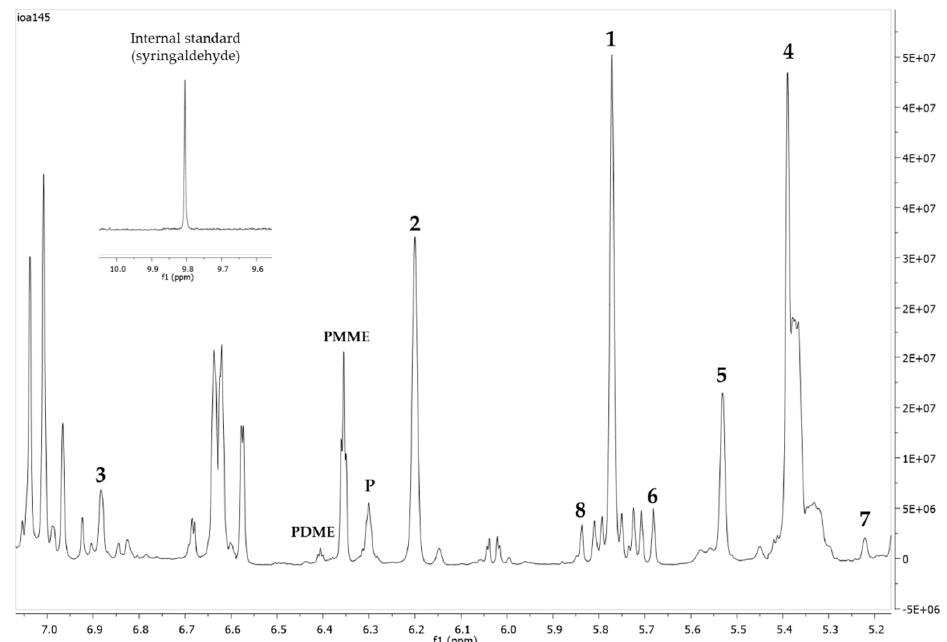
Figure 2. 1 H-NMR spectrum (400 MHz, CDCl 3 , δ -values in ppm) of black pine (P. nigra Arn.) heartwood extracts, showing the characteristic peaks of studied resin acids and internal standard. The numbers indicate the corresponding resin acids’ peaks used for quantitation: abietic acid ( 1 ), neoabietic acid ( 2 ), dehydroabietic acid ( 3 ), palustric acid ( 4 ), levopimaric acid ( 5 ), pimaric acid ( 6 ), sandaracopimaric acid ( 7 ), and isopimaric acid ( 8 ). Stilbenes’ peaks are also indicated (P = pinosylvin, PMME and PDME = monomethylether and dimethylether of pinosylvin, respectively).